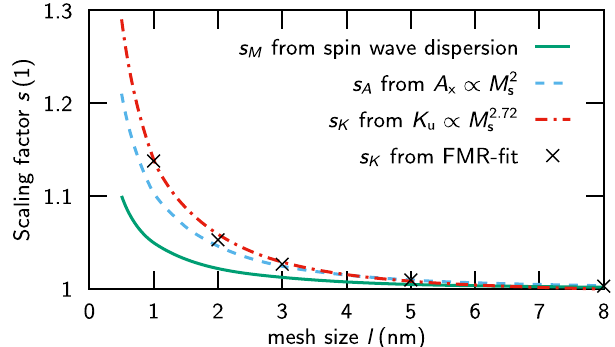
Fig. 3 Scaling of intrinsic properties. Scaling functions for intrinsic properties at a temperature of 300 K for Nd 2 Fe 14 B. While the scaling of the magnetization s M is derived from spin-wave theory, the scaling for the exchange stiffness constant s A follows A x / M 2 scaling for the magnetocrystalline anisotropy constant s K was determined by choosing K u to shift the FMR peaks of the various mesh sizes to the appropriate bias fi eld. s K can then be fi tted by / ð M l Þ 2 : 72 . K l u s Table 1. Scaling of intrinsic properties Values of scaling functions s and resulting intrinsic properties at the various mesh sizes l .